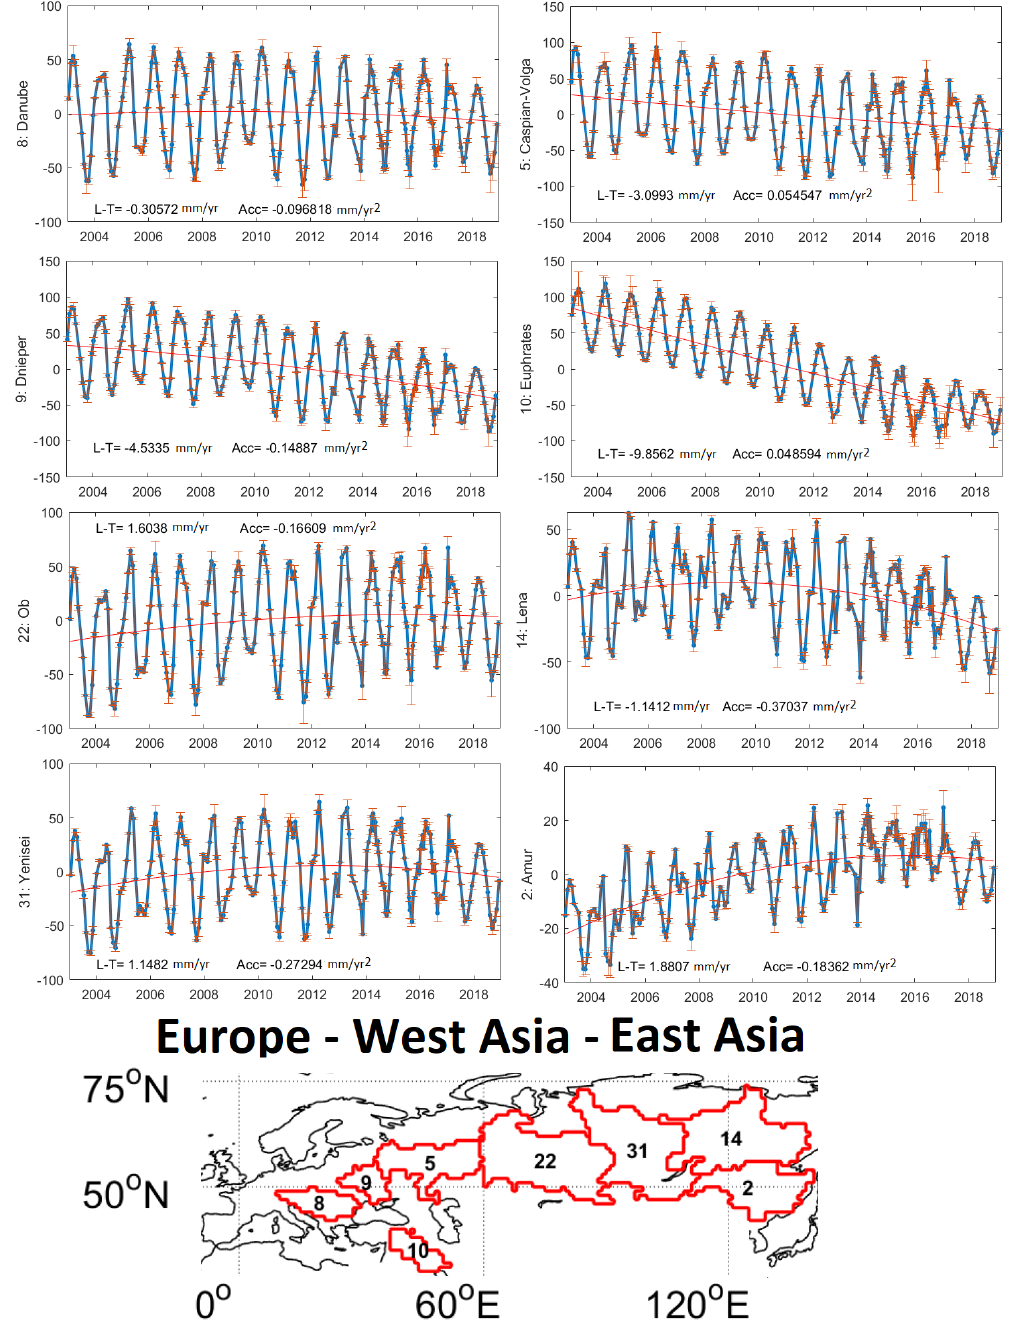
Figure 11. Basin averages of the reconstructed TWSC fields within the eight major river basins of the Europe and West-East Asia covering 2003–2018. The red lines show the long-term linear trend (L-T) mm/yr)) and acceleration (Acc (mm/yr 2 )) components fitted to the TWSC